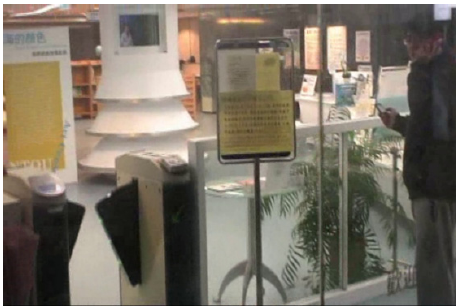
Figure 30. Smartphone remote control site.